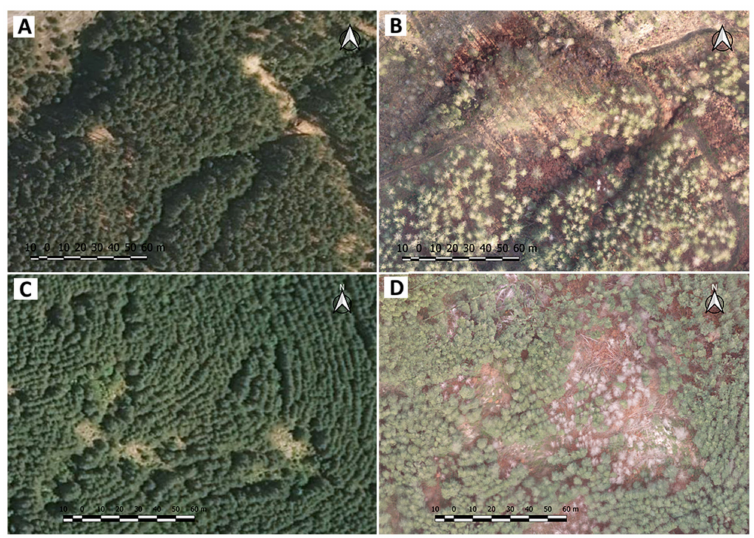
Figure 7. Pine plantations on RGB maps: ( A ) Fotinovo (2011); ( B ) Fotinovo (2019); ( C ) Kirkovo (2011); ( D ) Kirkovo